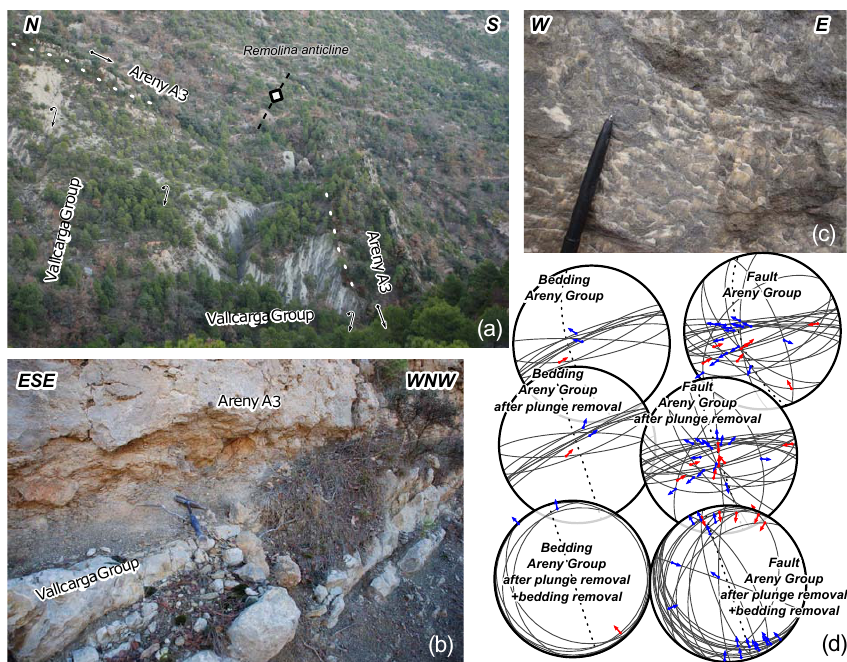
Figure 5. (a) Panoramic view of the hinge zone of the Remolina anticline, visible in the Areny strata that are on top of constantly dipping strata of the Vallcarga Group. (b) Detail of the unconformity between the Areny and Vallcarga groups at the southern limb of the anticline, where no evidence of shear occurs. (c) Detail of slickenlines along a near-vertical bedding surface of the Areny strata, providing a top-to- north slip sense for the upper bed. (d) Stereoplots of bedding surfaces and faults collected in the Areny Group strata of the southern limb of the Remolina